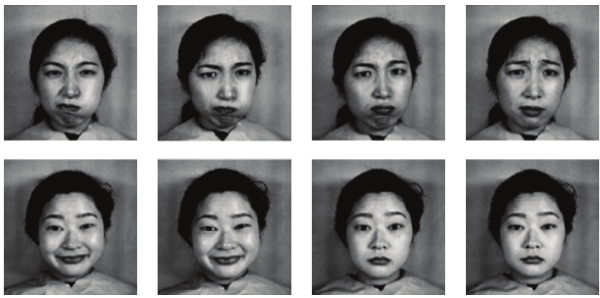
Figure 1: Some images in the Jaff facial expression database.